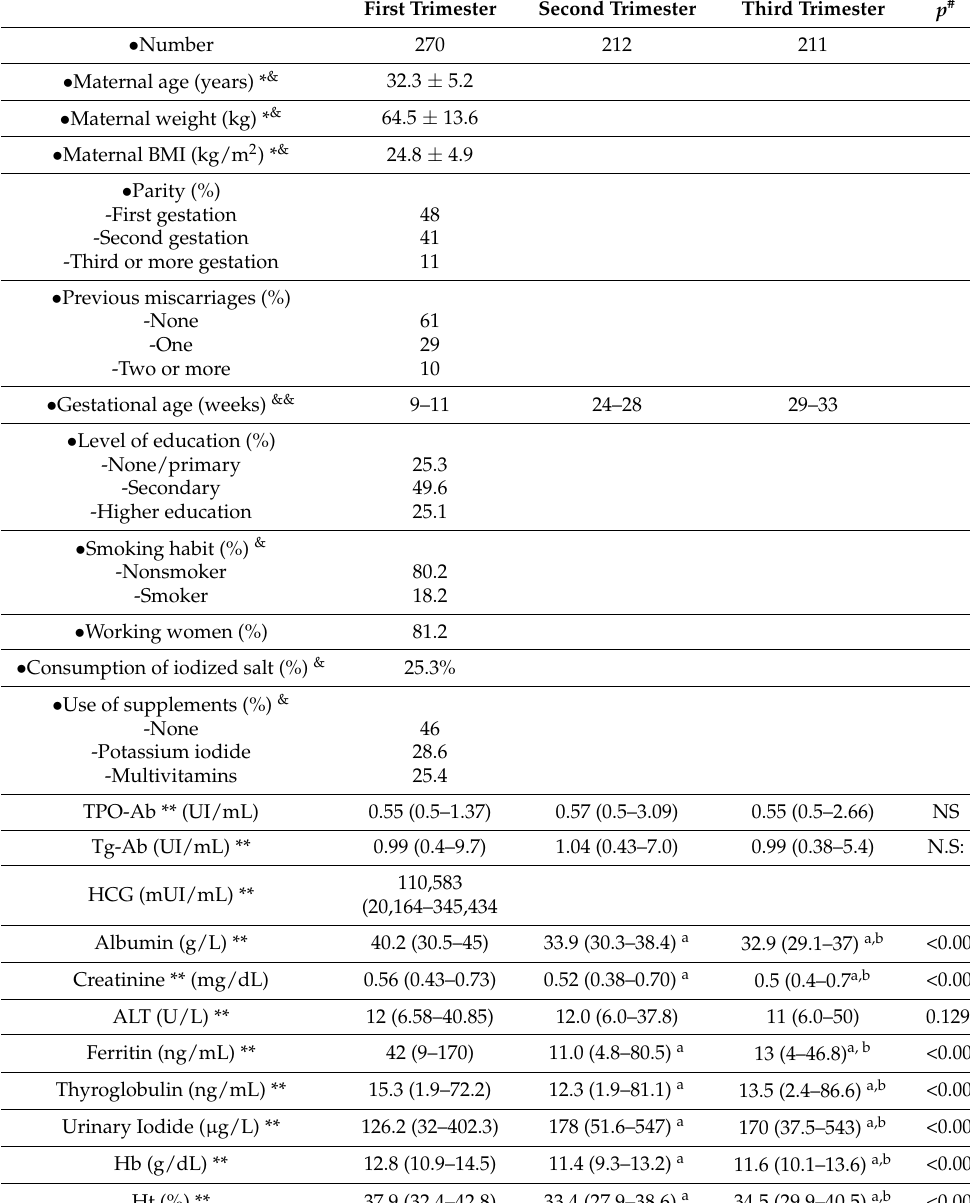
Table 1. Clinical and biochemical parameters in the negative TPO cohort at the three trimesters of pregnancy. First Trimester Second Trimester Third Trimester p